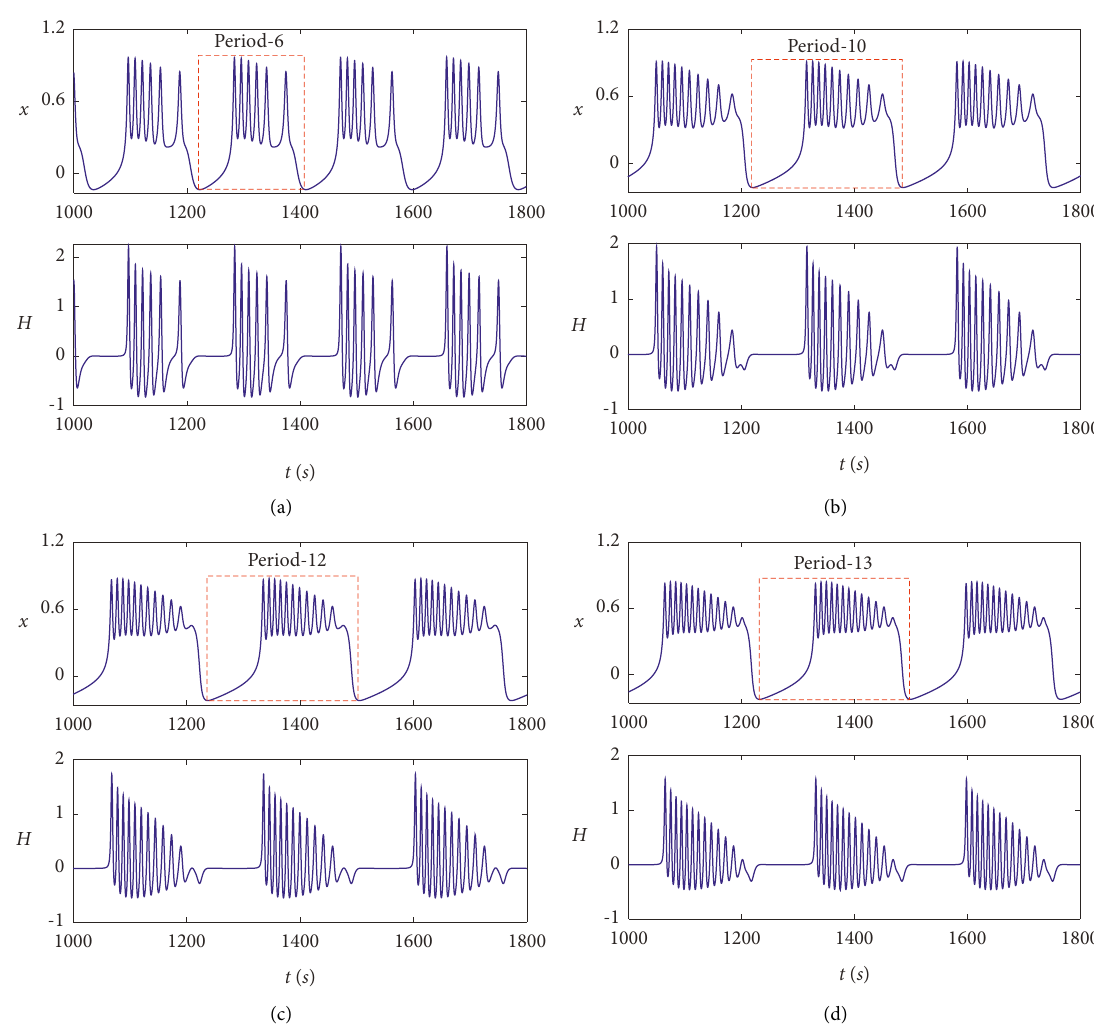
Figure 6: When n � 0 . 2, the discharge mode of system (10) and the responses of Hamiltonian energy under the feedback adjustment of ( H ) : (a) m � 0 . 04; (b) m � 0 . 08; (c) m � 0 . 12; (d) m � 0 . controller Γ 2